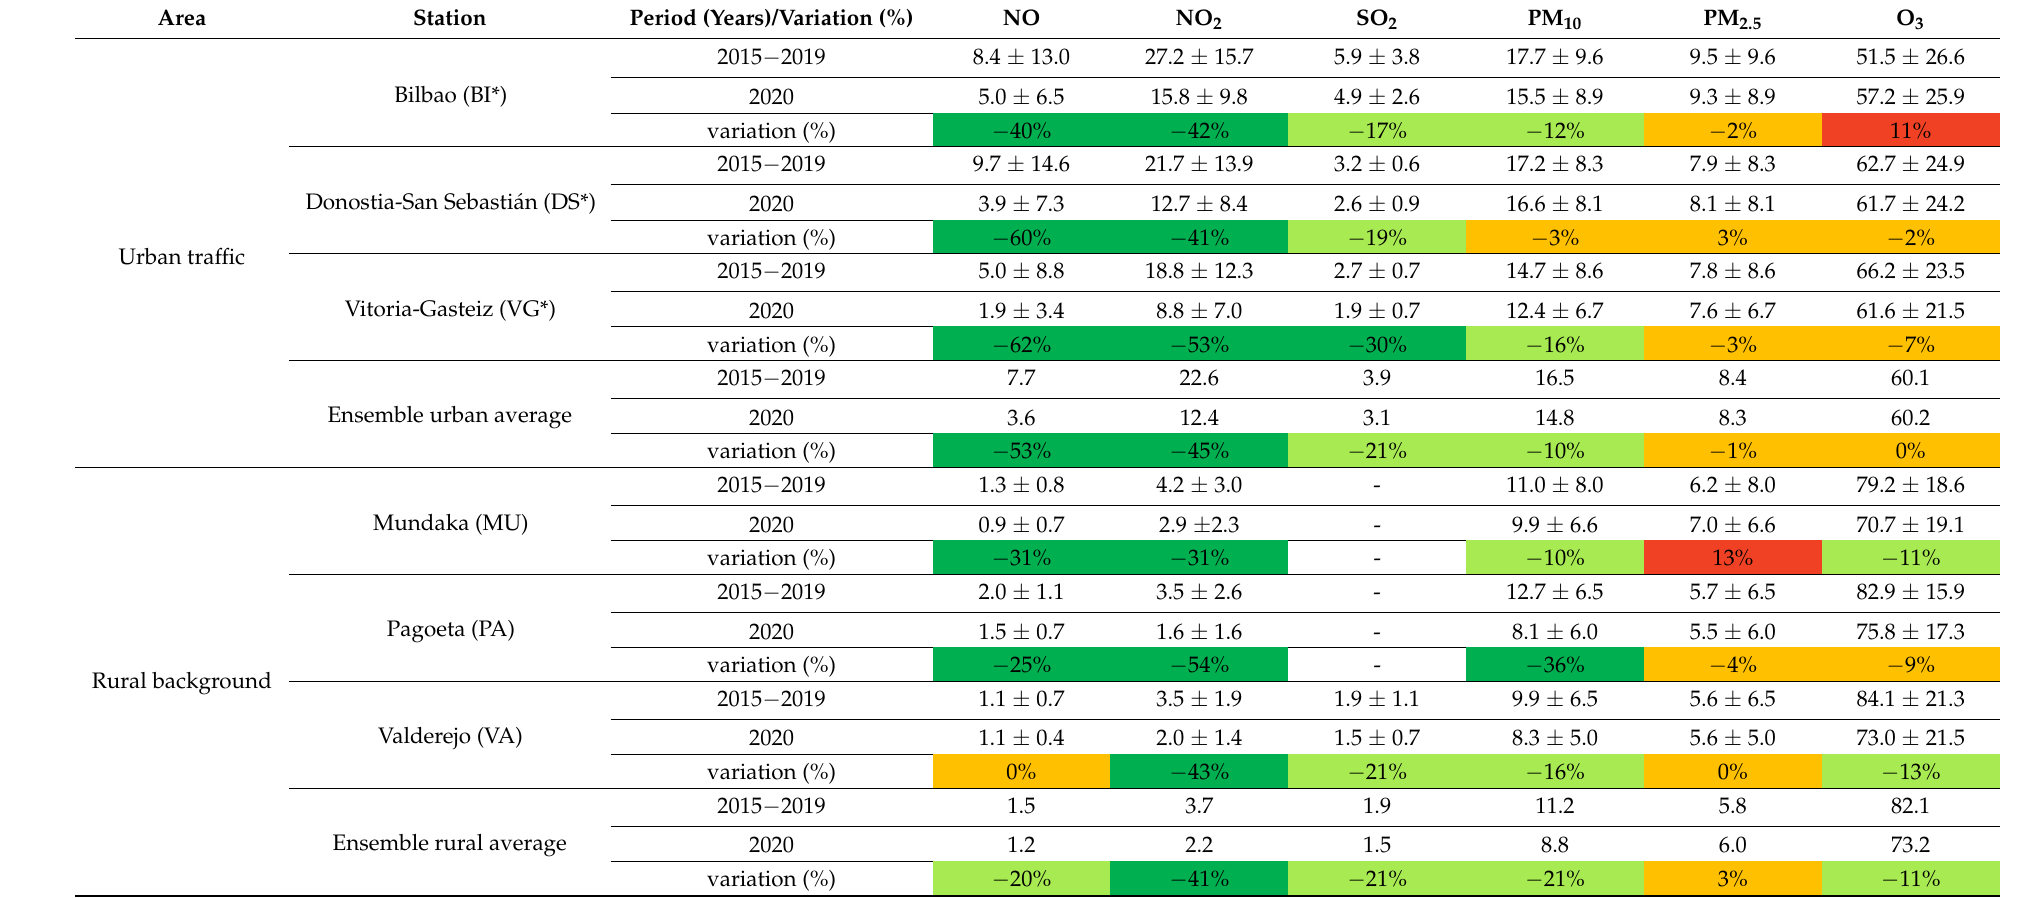
Table 6. Average and ± standard deviation of NO, NO 2 , SO 2 , PM 10 , PM 2.5 , and O 3 ( µ g · m − 3 ) concentrations during the lockdown period (2020) and previous years (2015–2019) at clustered urban traffic sites (marked with an asterisk) and selected rural sites in Basque Country. Ensemble urban and rural averages are also included. The percentage of reduction or increment during the 2020 lockdown with respect to 2015–2019 is included in shaded colors: Large reduction (up to − 25.0%), reduction (from − 24.9% to − 10.0%), Small reduction or increment (from − 9.9% to 10.0%), increment (above 10.1%). Clustered urban background and traffic sites are marked with an asterisk*